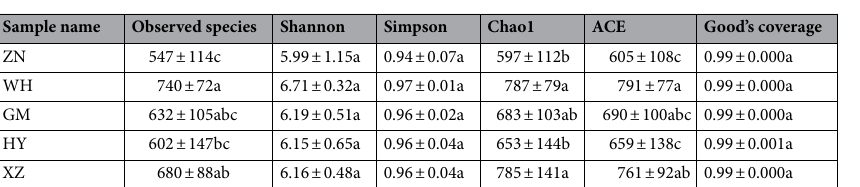
Figure 5. Spearman analysis between soil physicochemical factors and fungal phyla. SOM soil organic matter content, TN total nitrogen content in soil, TP total phosphorus content in soil, TK total potassium content in soil, XN nitrate nitrogen content in soil, AN ammonium nitrogen content in soil, SP available phosphorus content in soil, SK available potassium content in soil, PH soil pH value.